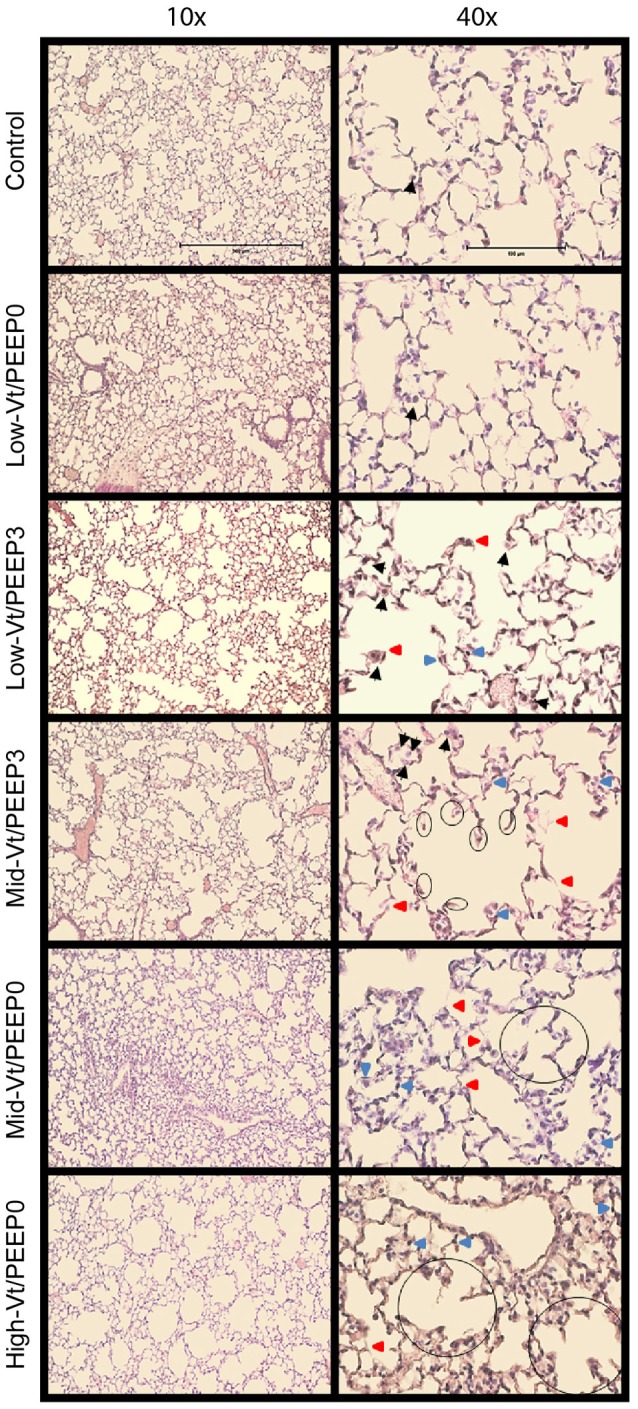
Representative microphotographs of H&E stained mouse lung sections at 10x and 40x magnifications. Black arrows point to macrophages, red arrows point to weakened, damaged, and thinner alveolar walls, and blue arrows point to dilated or congested capillaries. The already broken walls with retracted tissue are circled.